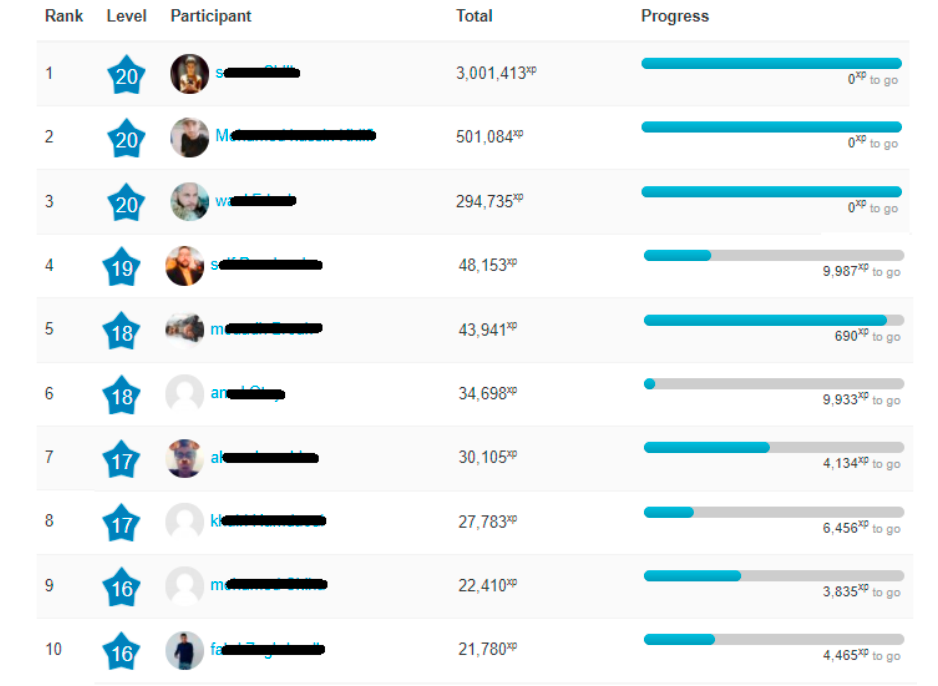
Figure 3. Leaderboard of the OODM course.